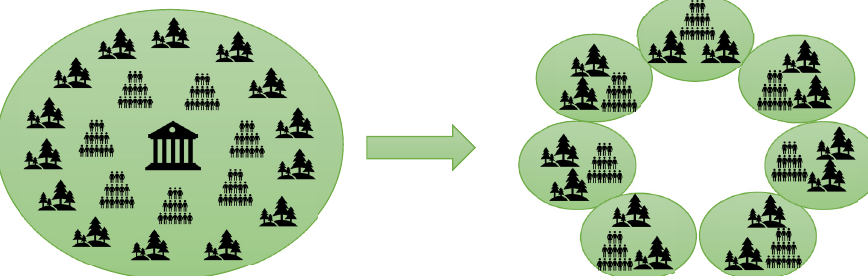
Figure 2. Devolving forests from the villagers’ committee to seven FUGs. Note: The left side and the right side of the figure illustrate forest management before and after the reform respectively. The parliament-like icon in the center of the left side represents the villagers’ committee, indicating that the villagers’ committee executed the powers of managing forests on behalf of all villagers before the reform. After the reform, forest management powers were devolved to seven FUGs, and the villagers’ committee did not play important roles in community forestry; therefore, the parliament-like icon is not included in the right side.